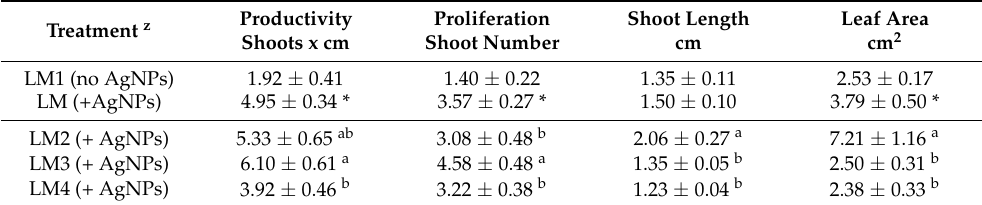
Table 2. Effect of AgNPs addition on micropropagation of ‘Mirlo Rojo’ apricot in different liquid